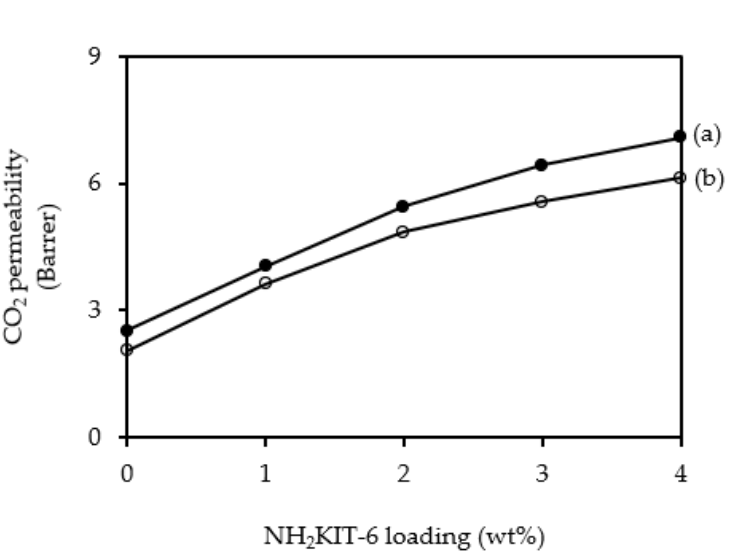
Figure 8. CO 2 gas permeability of the membranes incorporated with different NH 2 KIT-6 loadings at pressure differences of ( a ) 5 bar and ( b ) 7 bar.